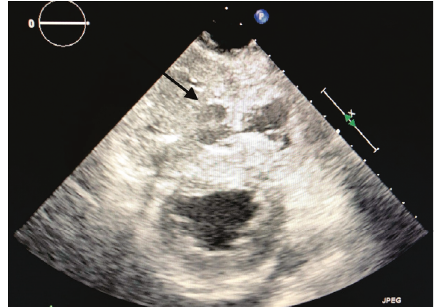
Figure 1: Transesophageal echocardiogram with ME AV LAX view showing extensive thrombus formation in the right ventricle.